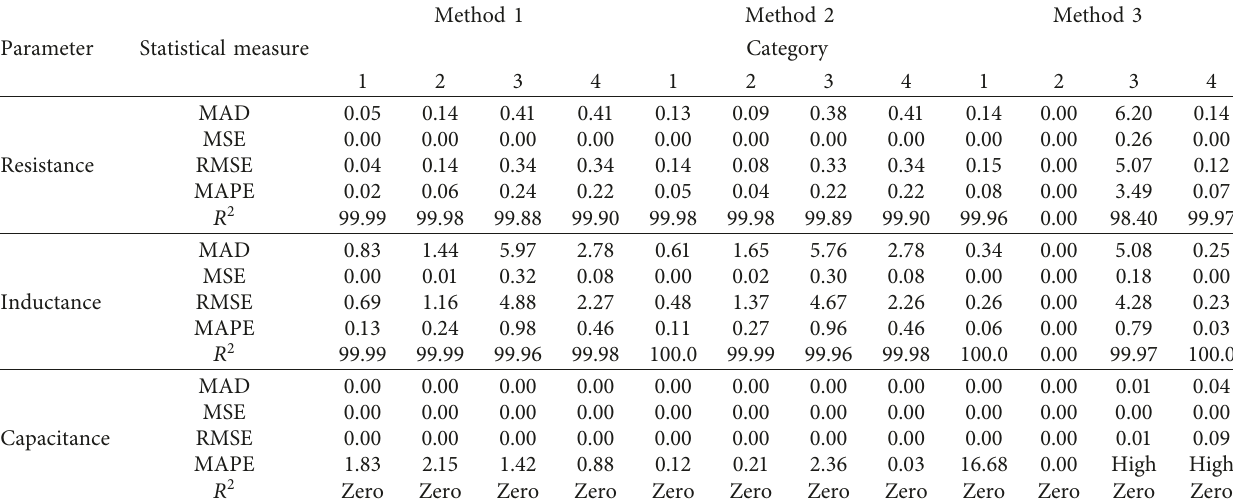
Table 5: Statistical measures results for all cases